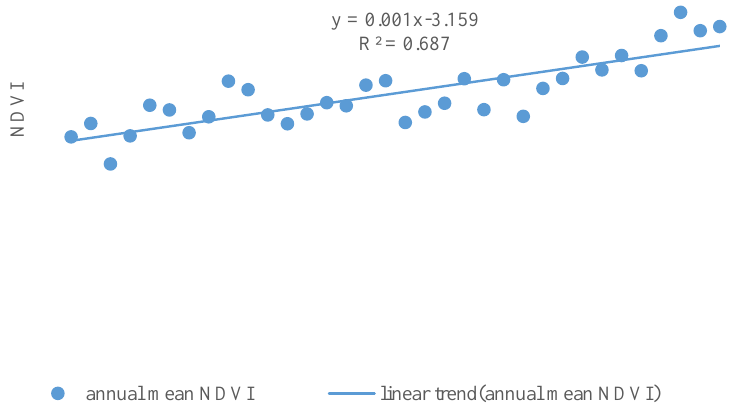
y = 0.001x-3.159 R² = 0.687